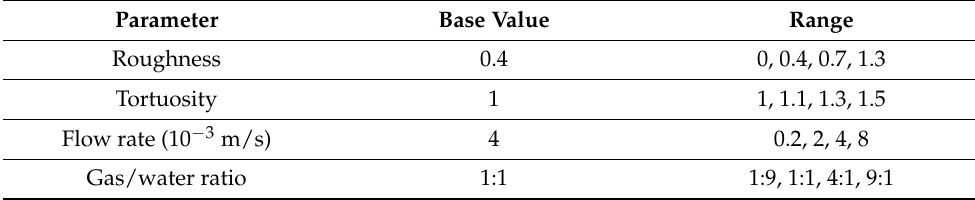
Table 1. Simulation scenario setup for the single-fracture models.